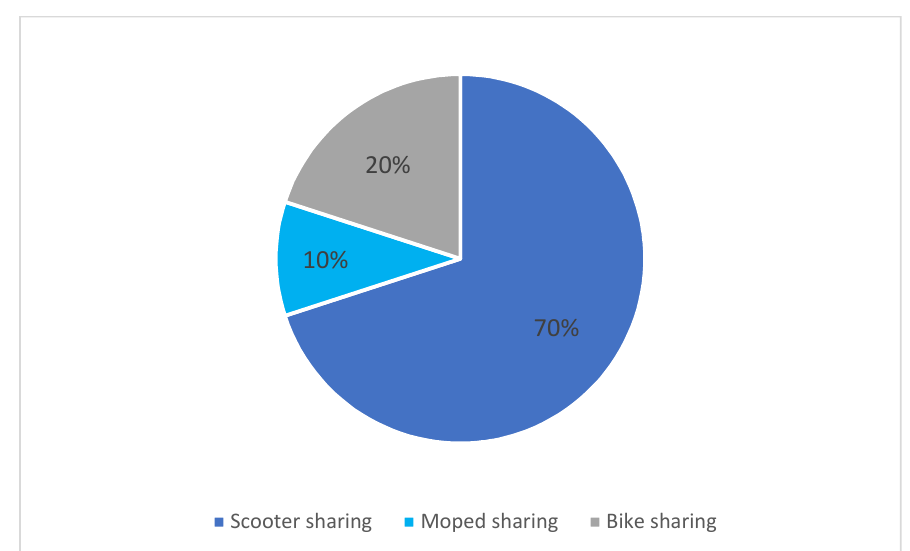
Figure 3. Open innovation enthusiasts in the shared mobility market.